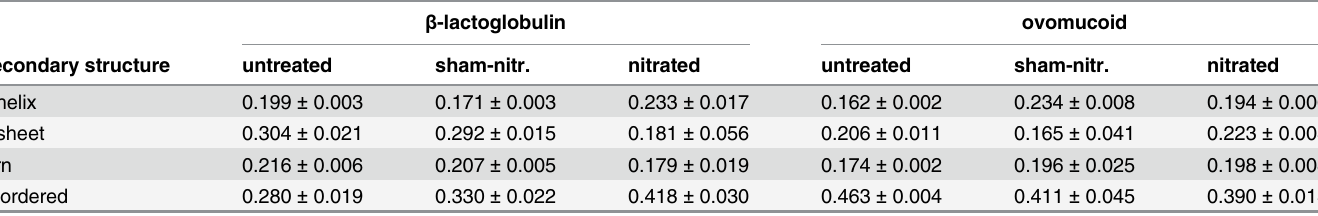
Table 1. Circular dichroism